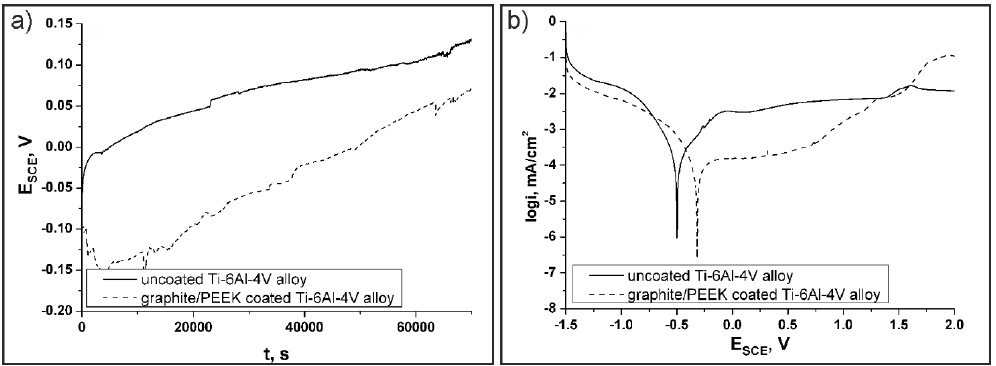
Figure 11. Electrochemical measurements of uncoated Ti-6Al-4V and graphite/PEEK coated Ti-6Al-4V alloy in 3.5 wt.% NaCl aqueous solution at 25 °C. Evolution of the corrosion potential vs. time ( a ) and polarization curves at 1 mV/s ( b ).